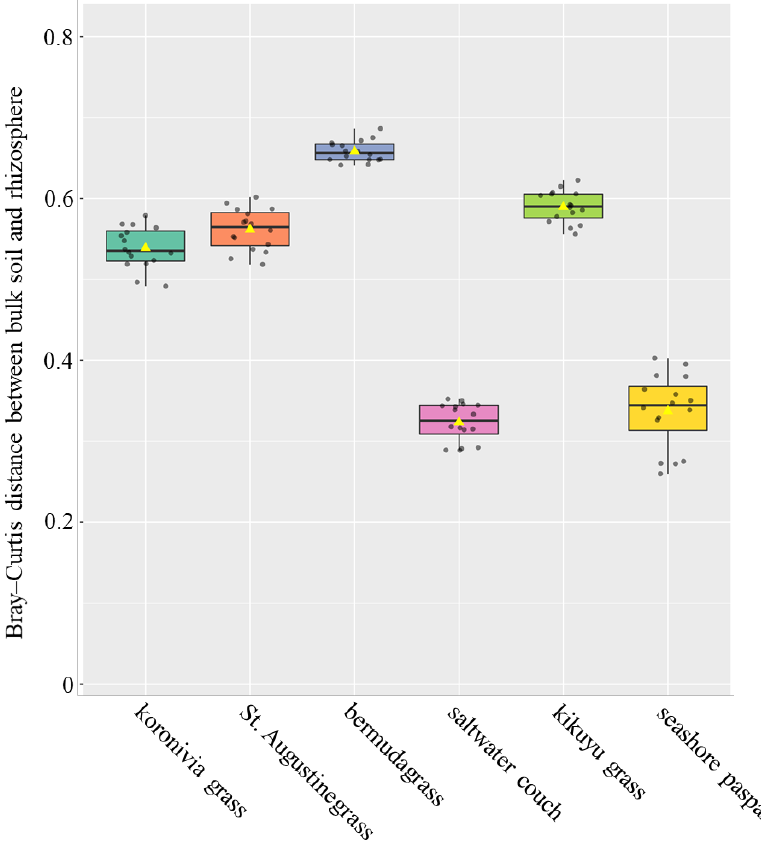
Figure 3. The differentiation of bacterial microbiome composition between bulk soil and rhizosphere soils of 6 perennial grasses. Bray–Curtis distance was used to indicate the difference in microbial ASVs’ composition between samples. In the boxplot, the values of individual samples are presented: the yellow triangle is the mean, and the box and central line represent first quartiles, medians, and third quartiles, respectively.